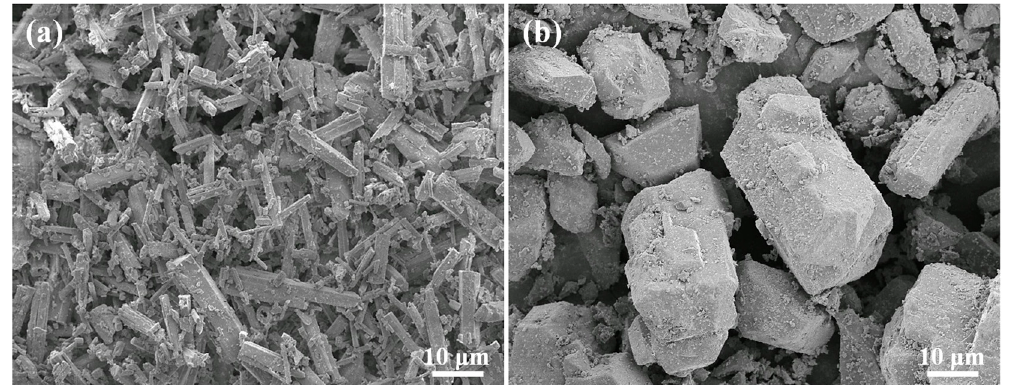
Figure 1. Electron microscope images of the implanted materials: ( a ) innovative α -calcium sulfate hemihydrate ( α -CSH) had uniform short column crystals around 10 µ m in length and ( b ) control α -CSH exhibited large and long column crystals around 50 µ m in length.